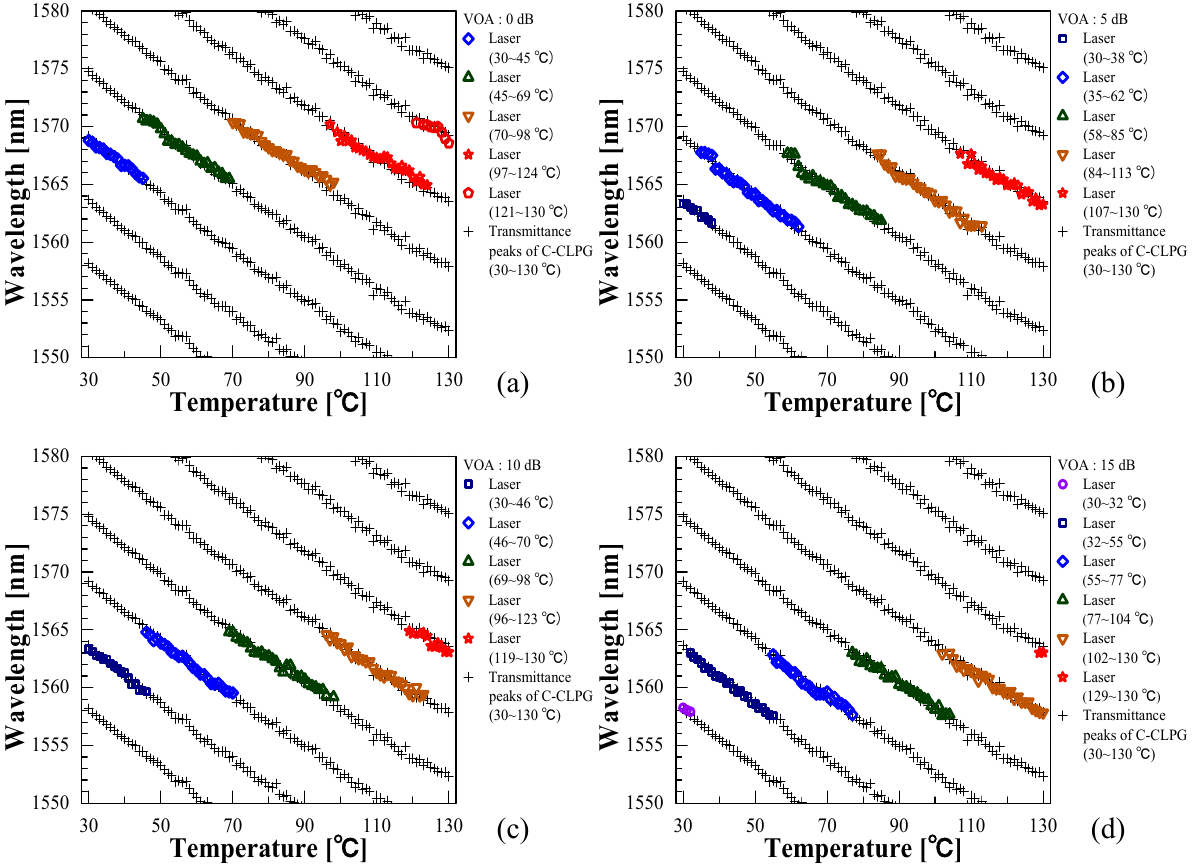
Figure 4. Oscillation wavelengths of EDFRL (colored symbol plots) and transmittance peak wavelengths of the C-CLPG (black cross plots) as a function of temperature for different VOA losses: ( a ) 0 dB, ( b ) 5 dB, ( c ) 10 dB, and ( d ) 15 dB.